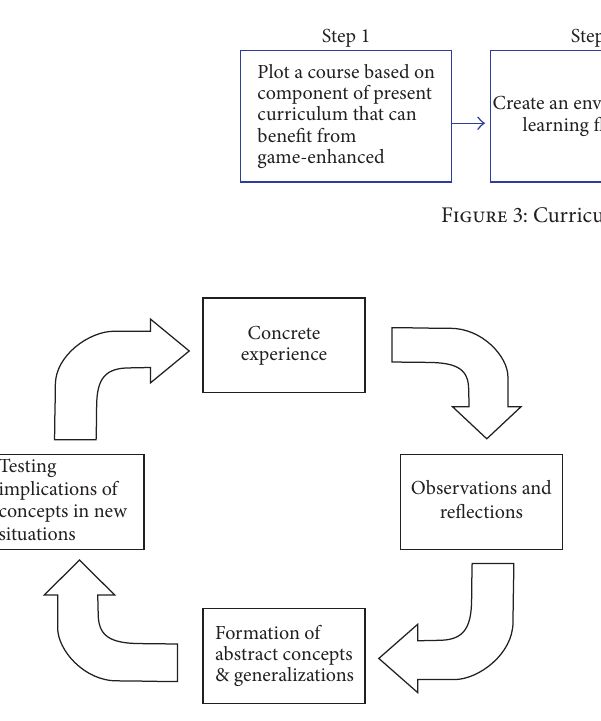
Figure 4: Kolb’s experiential learning model.